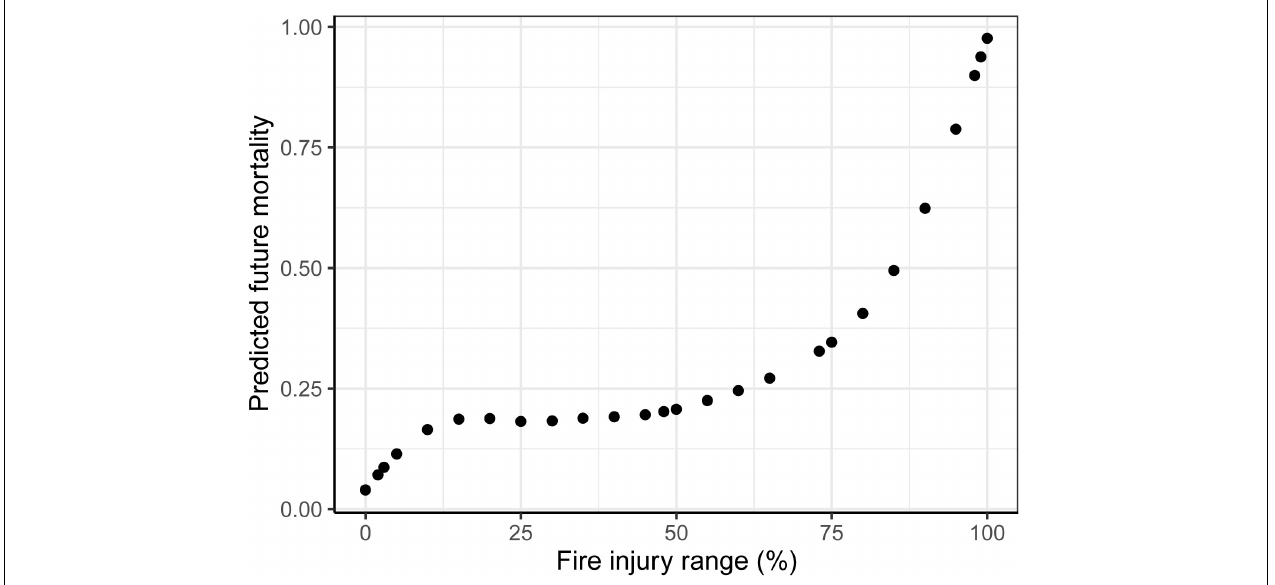
FIGURE 6 | Predicted mortality of saguaros ( Carnegiea gigantea ) post-fire. The range of fire injury of saguaros surveyed in the Mercer Fire site gives the prediction of their future mortality. The prediction is based on a relationship presented Esque et al. (2004).